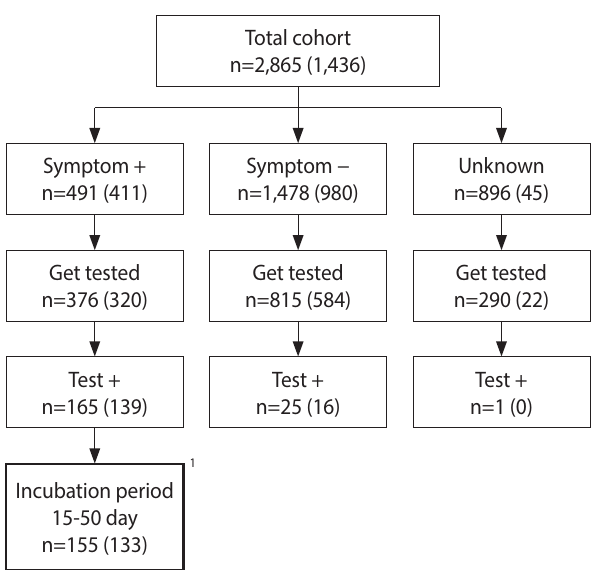
Figure 1. Study flow of the restaurant A visitor cohort study. The numbers in parentheses indicate the number of people who re- sponded to the food intake history. 1 Eligible for